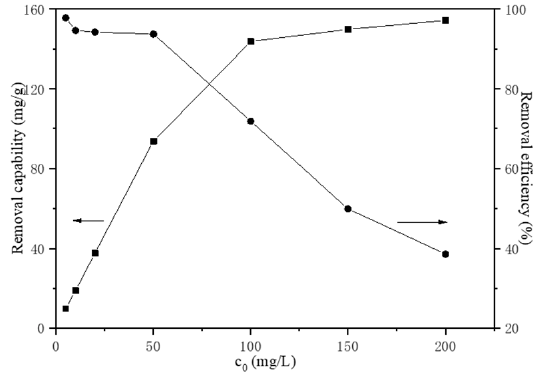
Figure 5. The effect of initial Fe(III) concentration .